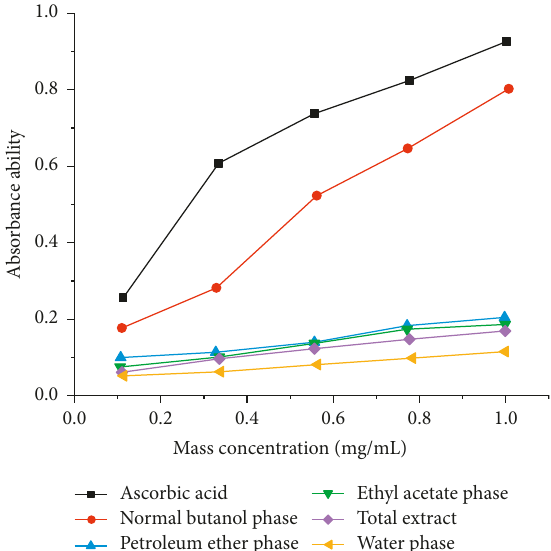
Figure 4: The scavenging ability of different extraction parts of Huai Mi ethanol extract on light free radicals ( n � 3).